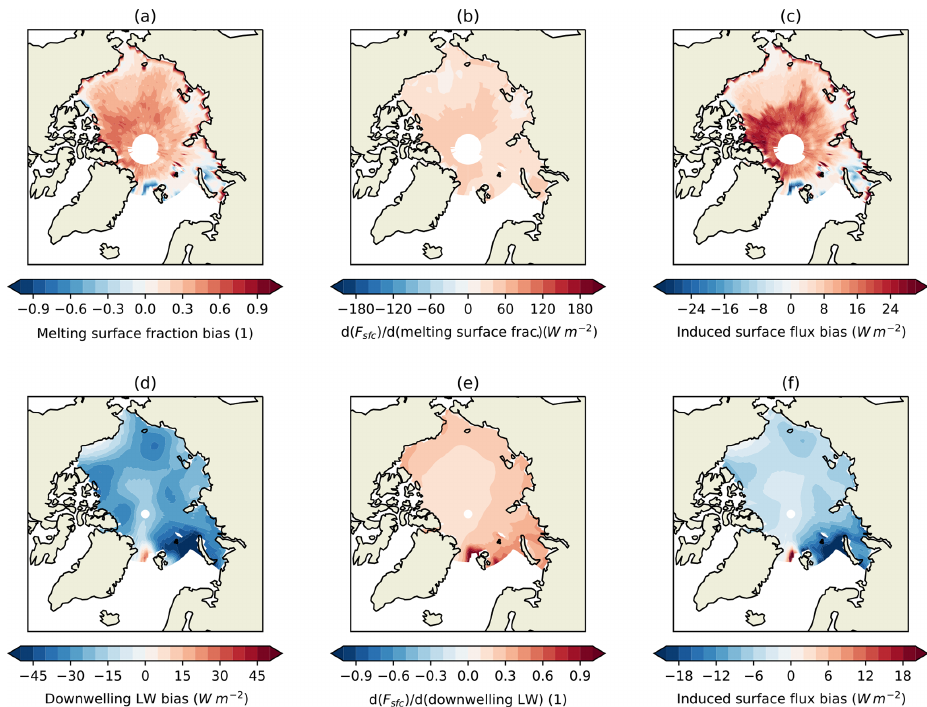
Figure 6. Demonstrating the calculation of fields of surface flux bias due to model bias in melting surface fraction (a) – (c) and downwelling LW (d) – (f) . (a) and (d) show model bias in each variable, (b) and (e) the local rate of dependence of surface flux on each variable as calculated above, and (c) and (f) the induced surface flux bias, calculated as the product of these two fields. The first historical simulation of HadGEM2-ES is used for the